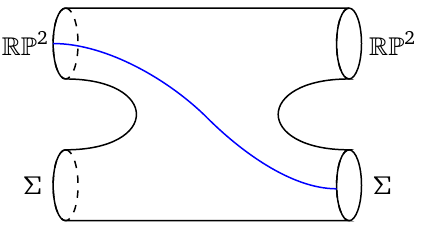
Figure 5: A bordism between (cid:82)(cid:80) 2 × Σ and itself, with a real vector bundle V (cid:48) on it. The blue line represents the Poincaré dual of w